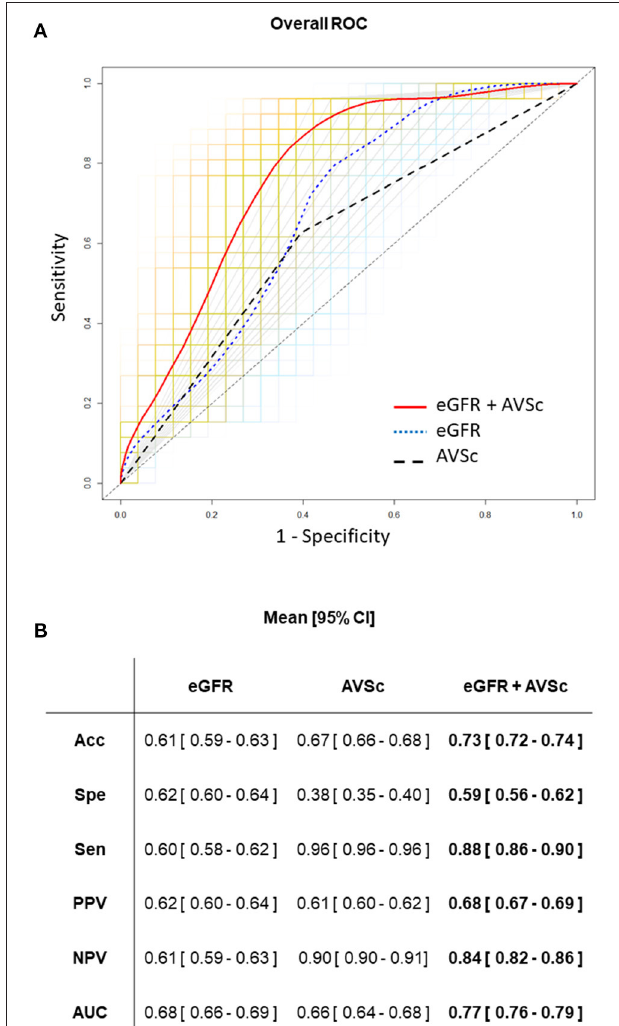
FIGURE 4 | Predictive ability of eGFR and AVSc for the 5-year all-cause mortality in patients with mixed-fibrotic plaque. (A) The average performance of the three logistic models are shown as ROC curves, where the predictors are aortic valve sclerosis (AVSc; dash black line), estimated glomerular filtration rate (eGFR; dot blue line), and the combination of AVSc and eGFR (red solid line). The grids represent the 1,000 bootstrap iterations (ROC curves) plotted for AVSc (gray), eGFR (light blue), and the combination of AVSc and eGFR (orange). (B) Acc, Classification accuracy; Spe, specificity; Sen, sensitivity; PPV, positive predicted value; NPV, negative predicted value; AUC, area under the ROC curve are summarized as mean and 95% CI for each model took into